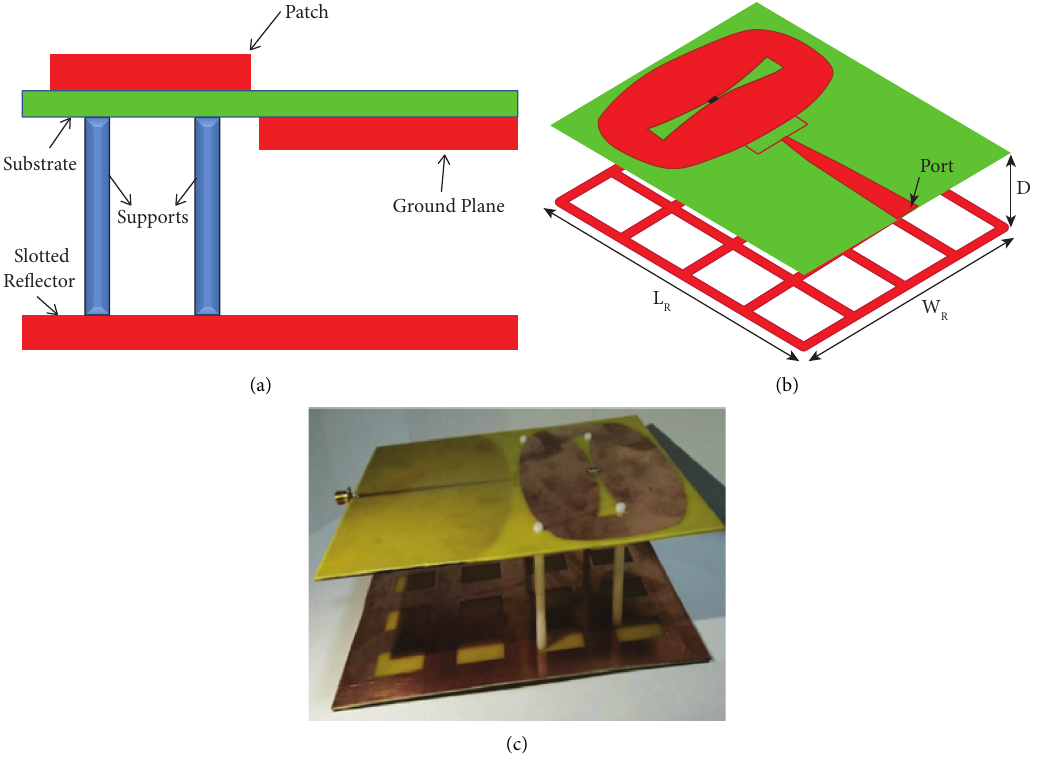
Figure 2: Geometry of the reflector-backed antenna: (a) side view (b) 3D view; (b) reflector-backed fabricated